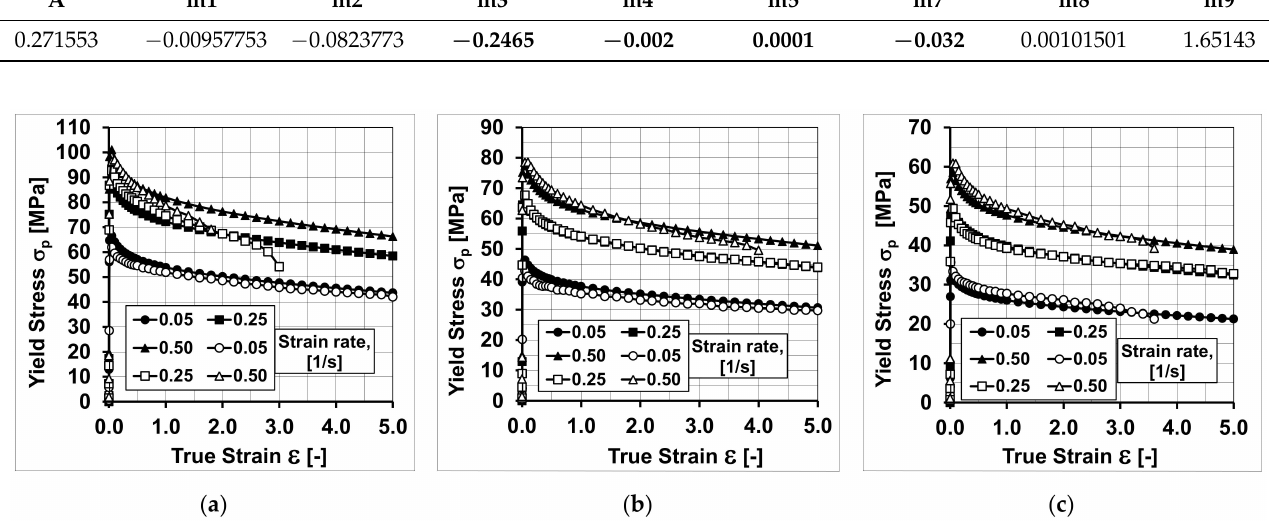
Figure 10. Flow curves of the 5019 aluminium alloy at temperatures of ( a ) 440 ◦ C; ( b ) 480 ◦ C; ( c ) 520 ◦ C; empty symbols— plastometric test data; full symbols—results after approximation using coefficients from Table 2 (Variant